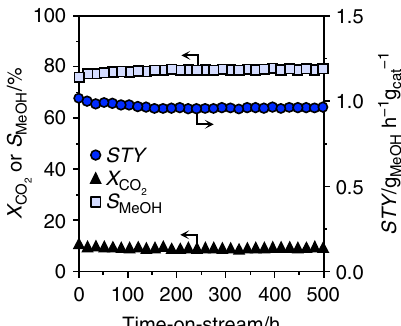
Fig. 6 Extended stability test of the best palladium-promoted In 2 O 3 catalyst.